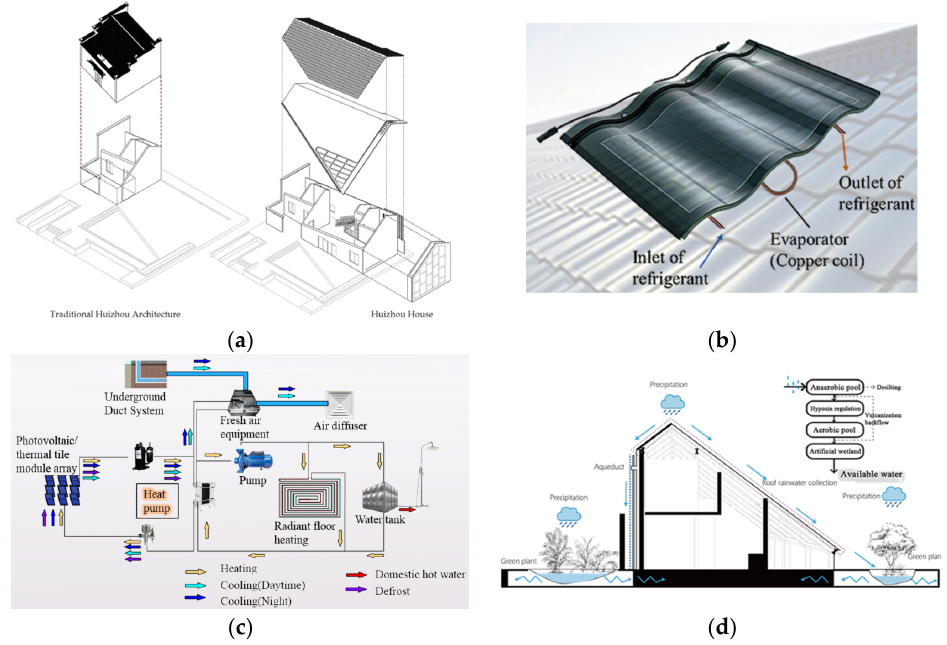
Figure 8. Main results of the HUI House. ( a ) Modern Huizhou architecture. ( b ) Solar chips. ( c ) Mul- tifunctional supplying system. ( d ) Rainwater use system.